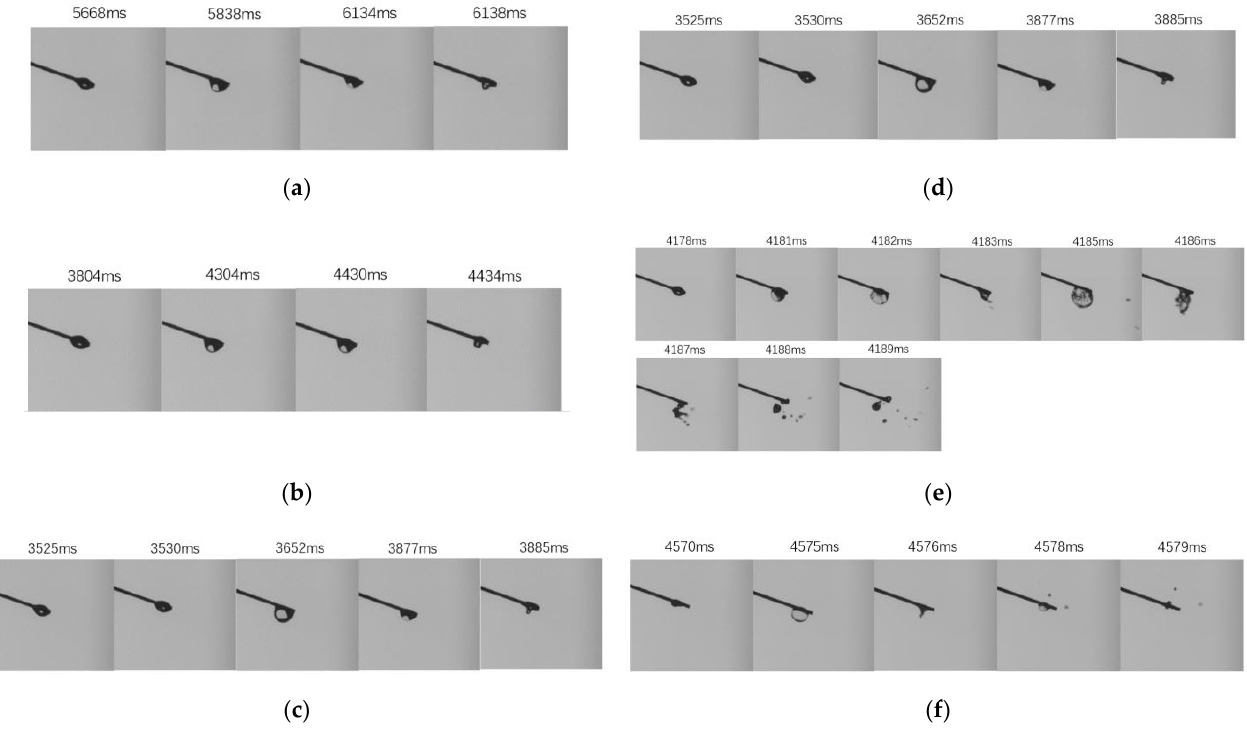
Figure 10. Micro-explosions observed at 0.8 bar: ( a ) 673 K; ( b )773 K; ( c ) 823 K and 0.6 bar: ( d ) 673 K; ( e ) 773 K; ( f ) 823